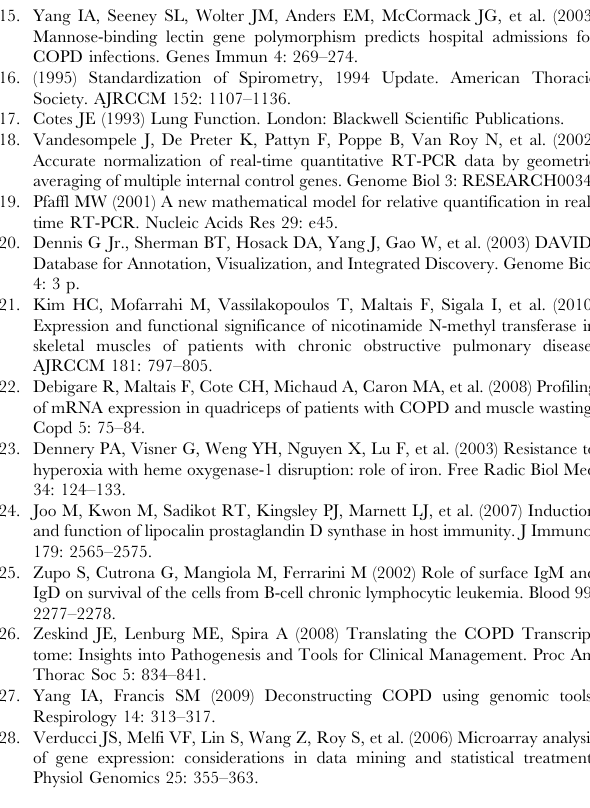
Table S7 Gene ontologies enriched in Spira et al DLCO dataset. Table S8 Gene ontologies enriched in Golpon et al DLCO dataset. Table S9 Gene ontologies enriched in Savarimuthu et al TPCH- KCO